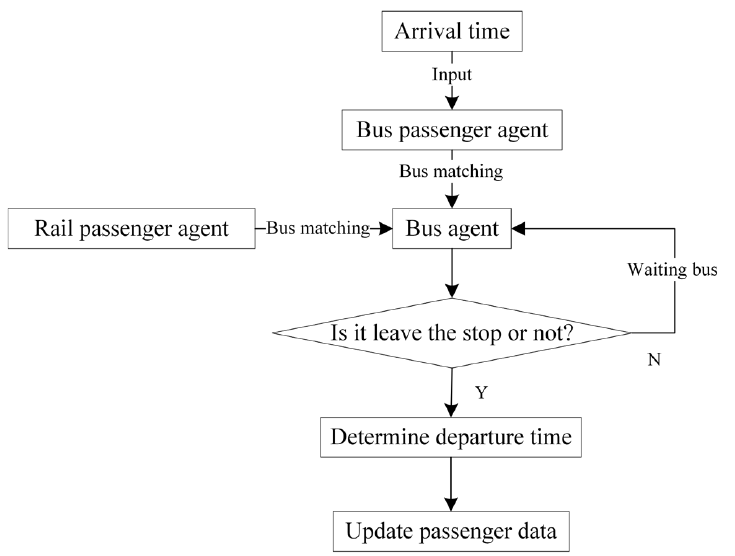
Figure 6. Main function of bus passenger agent.